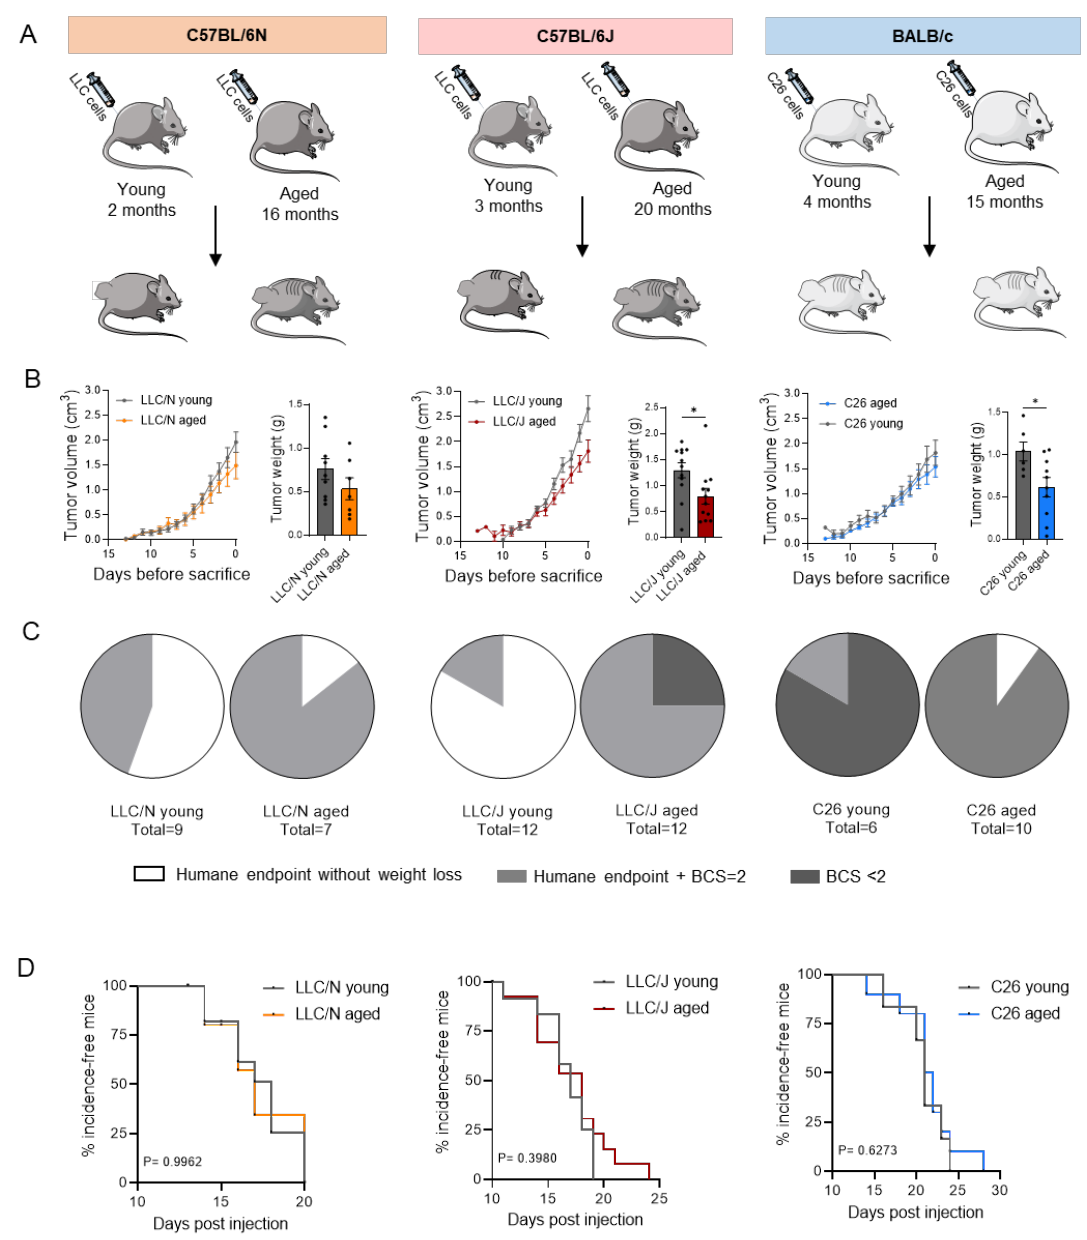
Figure 1. Tumor growth is largely unaffected by age in different mouse models with various tumor entities. ( A ) Diagram presenting three different cachexia mouse models including groups of several ages. Mice were injected with different tumor cell lines (LLC and C26). C57BL/6N (orange) — comparison of young adult (2 months, grey, n = 9) and aged (16 months, orange, n = 7) LLC-injected C57BL/6N mice. C57BL/6J (red — comparison of young adult (3 months, grey, n = 12) and aged (20 months, red, n = 12) LLC-injected C57BL/6J mice. BALB/c (blue) — comparison of young adult (4 months, grey, n = 6) and aged (15 months, blue, n = 10) C26-injected BALB/c mice. ( B ) Tumor growth over time and tumor weight at the end of the experiment in young and aged LLC/N, LLC/J, and C26-BALB/c mice. ( C ) Pie charts representing the primary termination criteria of tumor-bearing mice. We differentiated between animals that reached the humane endpoint but had a stable bodyweight (white) versus mice that reached the humane endpoint and simultaneously had already lost between 3 – 10 % of body weight (BCS = 2, light grey). Animals with a BCS < 2 were terminated due to cachexia. ( D ) Incidence-free time between young and aged tumor cell-injected LLC/N, LLC/J, and C26-BALB/c mice. Data are mean ± s.e.m. Statistical analyses were performed using unpaired t -test or Mann – Whitney test ( B ), and log-rank (Mantel – Cox) test ( D ). * p < 0.05.